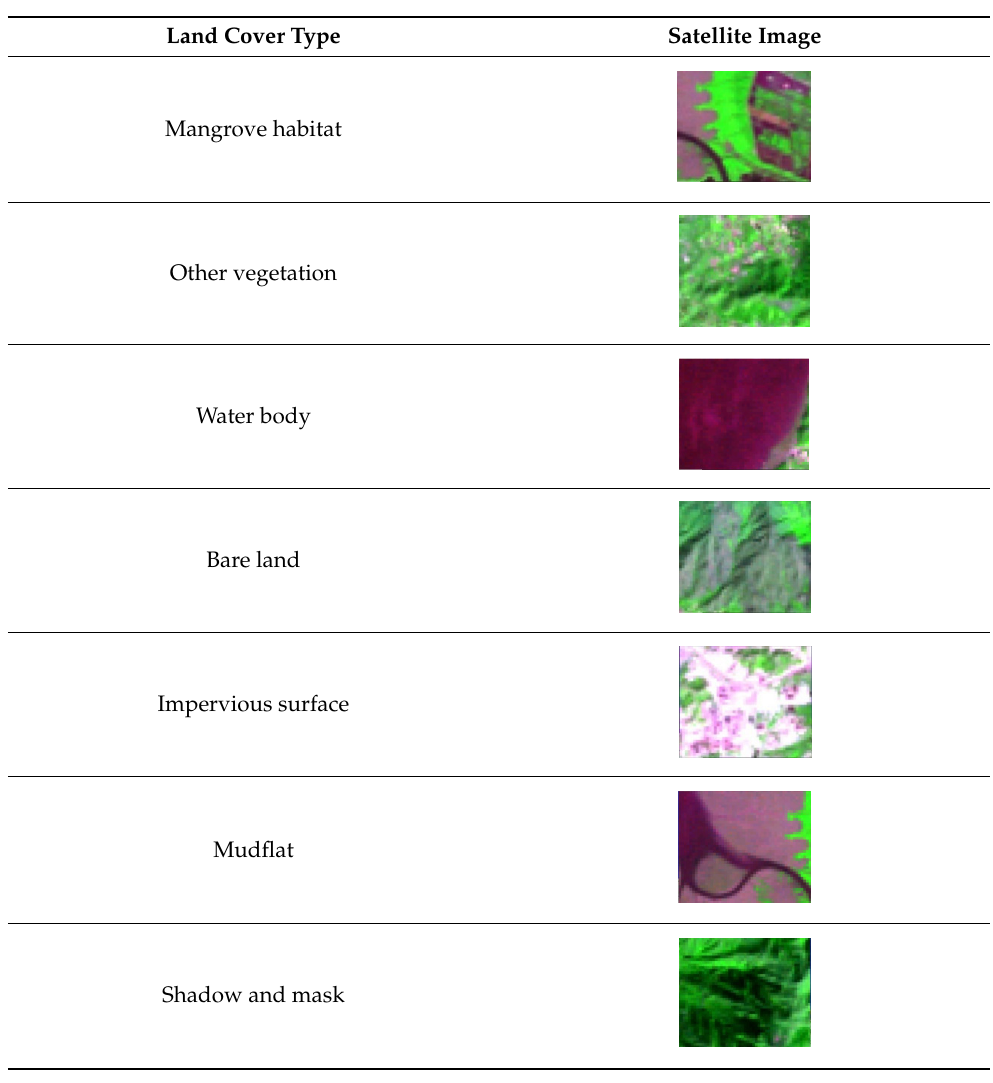
Table 1. Land cover classification categories for Landsat data.